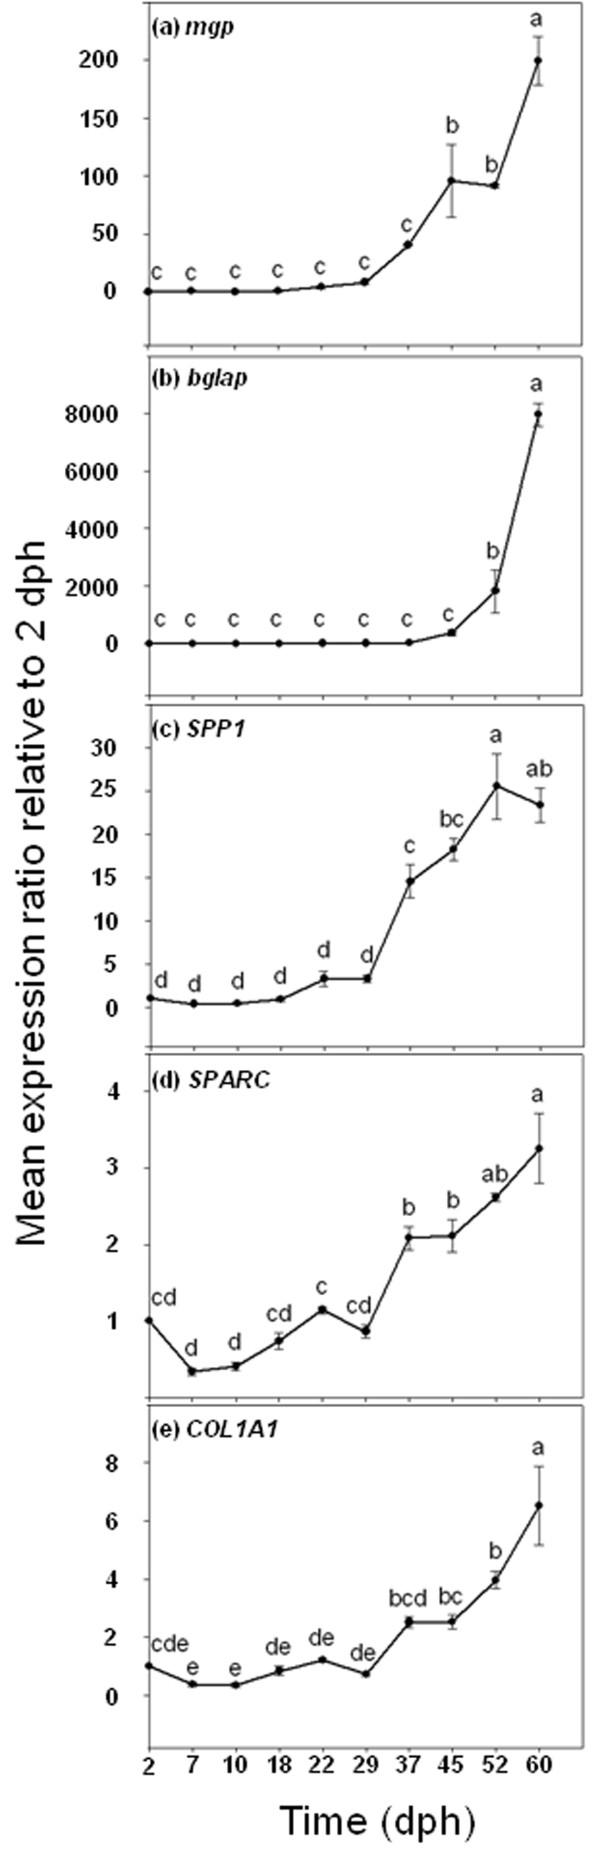
Ontogenetic gene expression patterns of mgp (a), bglap (b), SPP1 (c), SPARC (d), and COL1A1 (e). Gene expression measured as the mean expression ratio of the target gene respect to the house-keeping gene (EF1α) at each sample time compared with initial sample time (2 dph). Different letters denote significant differences of the global gene expression (ANOVA, P < 0.05; n = 3).